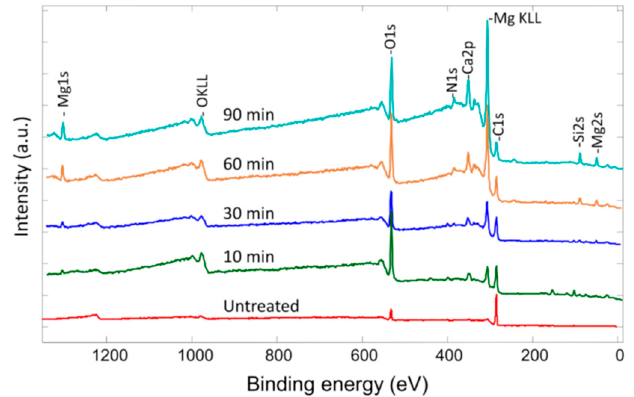
Figure 4. XPS survey spectra of initial ‐ and plasma ‐ treated Mung bean seeds.